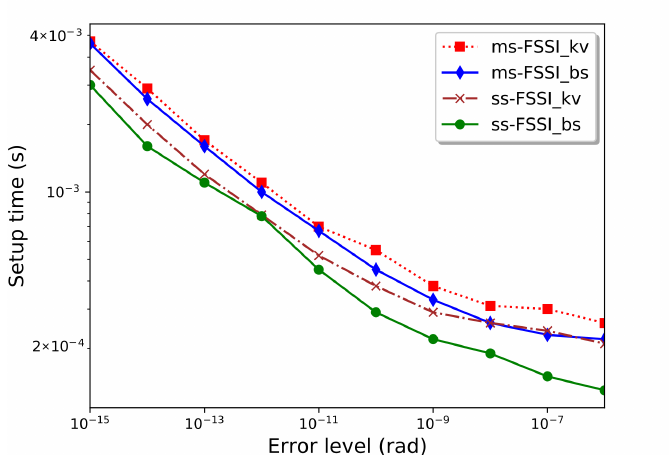
Figure 3. CPU execution time (s) as a function of the error level for the setup of different routines, as applied to the inversion of f ( x ) = x e sin x with e = 0.9. These results have been obtained with the − computer hardware specified in the